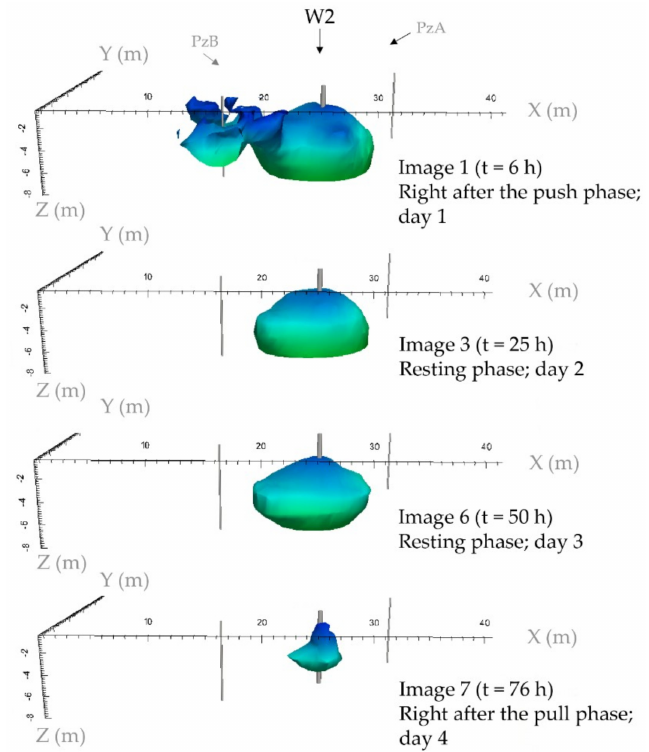
Figure 8. Plain view showing changes in bulk electrical resistivity at di ff erent time steps showing the thermal plume right after the end of the push phase (1st panel), one day (2nd panel) and two days after (3rd panel) during the resting phase, and finally right after the pull phase (4th panel). The filtering scheme is explained in Figure 7.